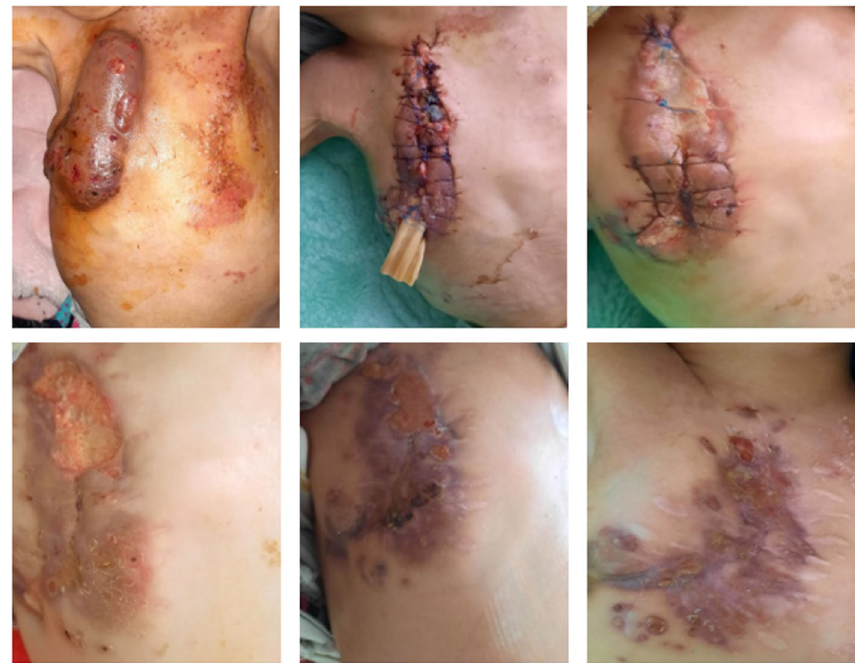
Fig. 1 The time course of the skin lesion after surgical debridement and while receiving voriconazole shows marked improvement and practically complete